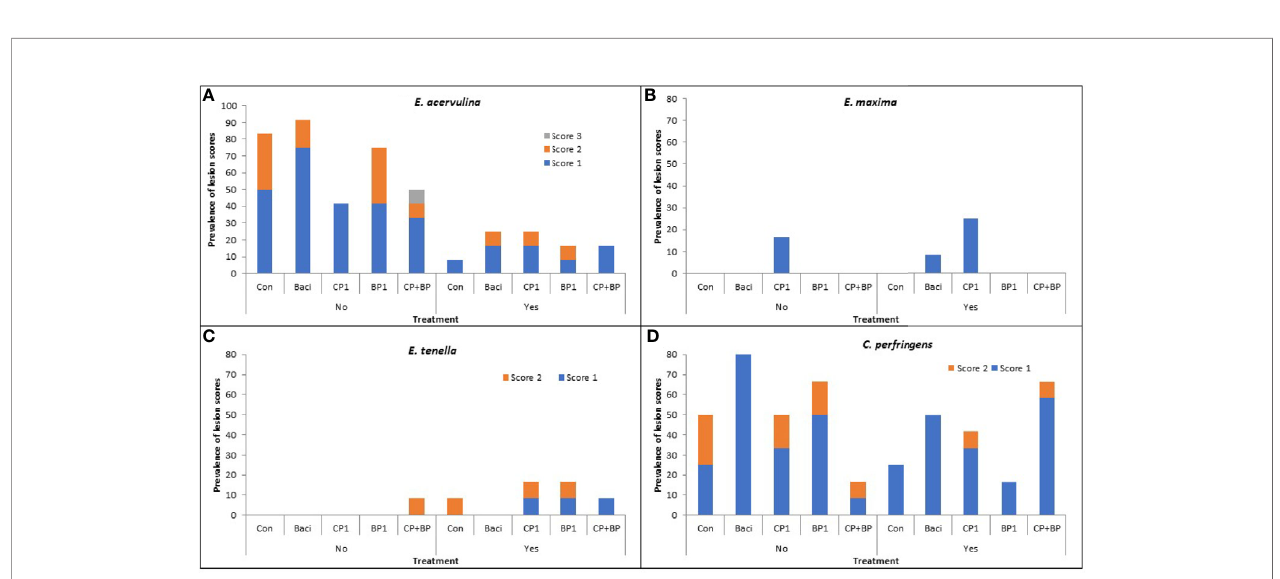
FIGURE 2 | Effects of dietary treatment on the severity and prevalence of coccidiosis lesions due to (A) E. acervulina , (B) E. maxima , (C) E. tenella , and (D) necrotic enteritis due to C. perfringens in both vaccinated (Yes) or non-vaccinated (No) chickens at 21 day of age. Control, birds fed basal diet; BACI, birds fed basal diet with 55 ppm bacitracin; basal diet supplanted with cranberry pomace 1% (CP1); blueberry pomace 1% (BP1); and cranberry 1% + blueberry 1% pomaces together